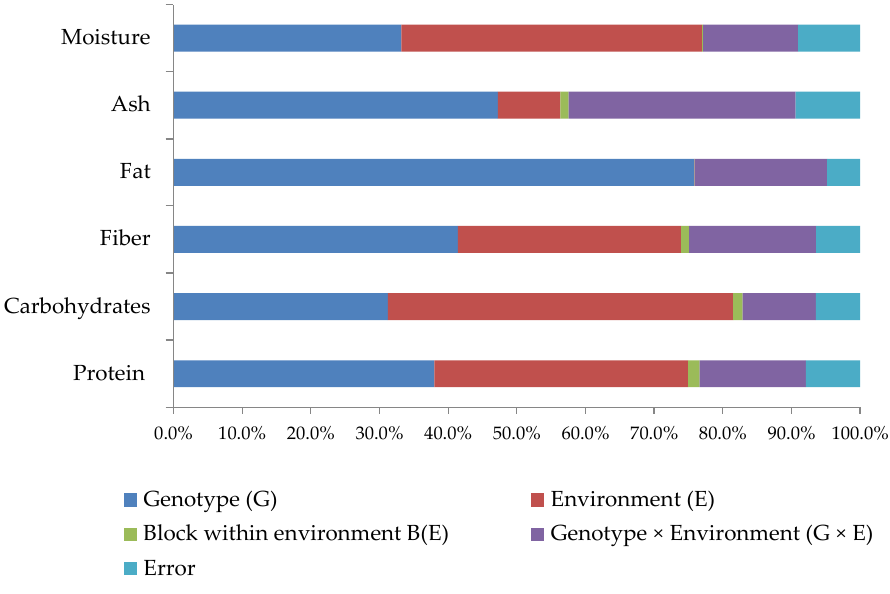
Figure 3. Genotype, environment and genotype × environment interaction’s contribution (Eta 2 %) to general nutritional parameters’ variability in common bean accessions.